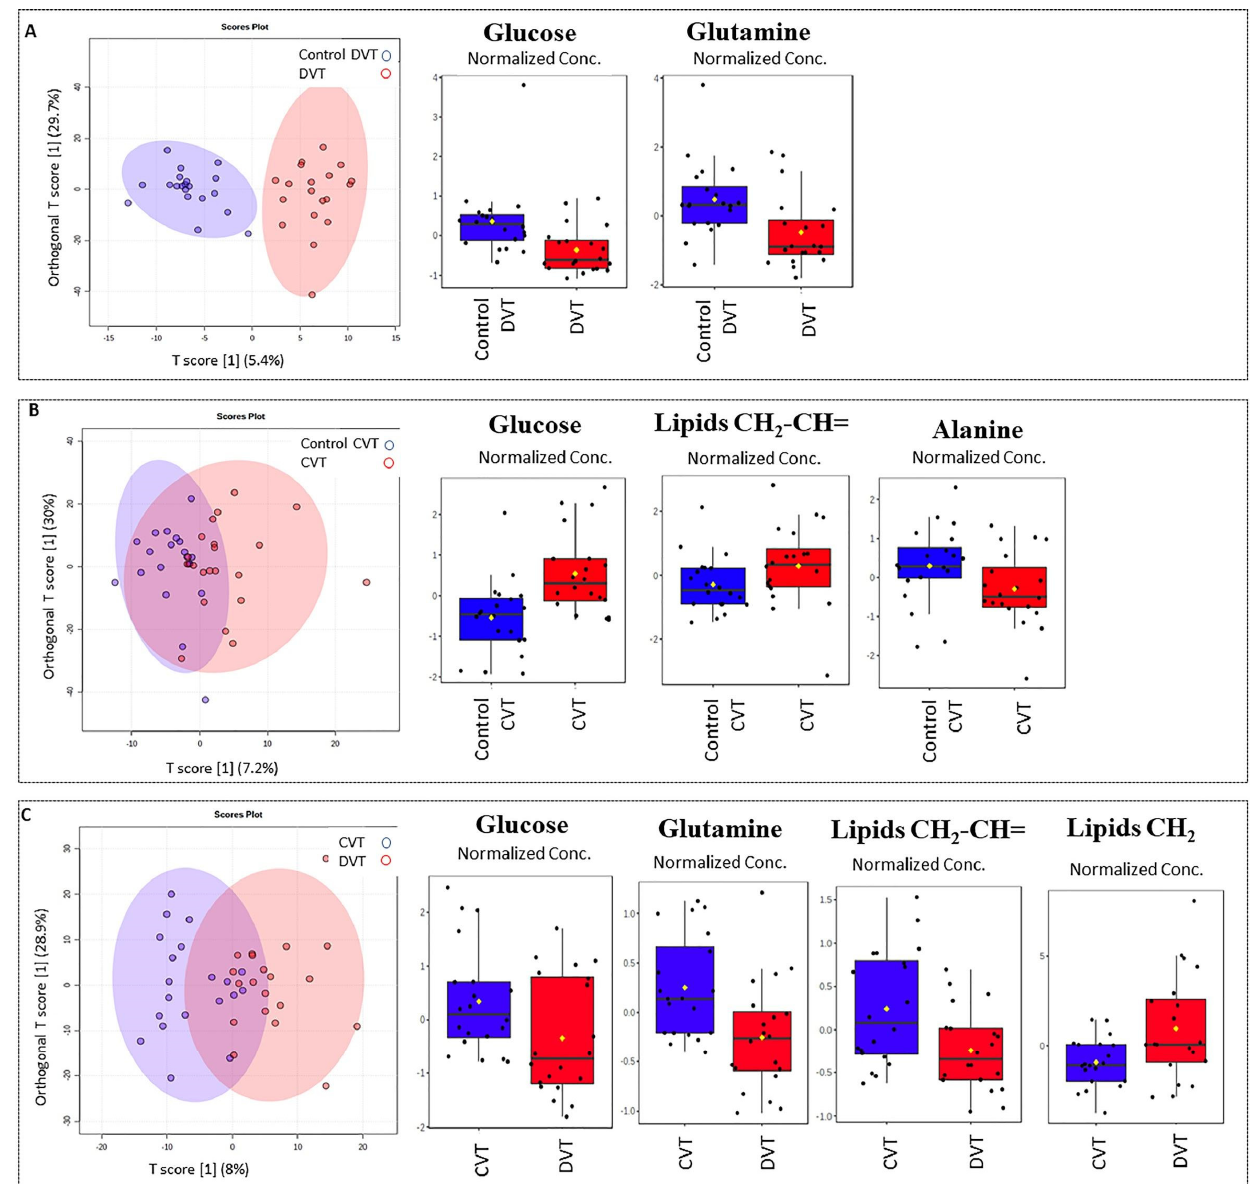
Figure 3. Illustration of results of OPLS-DA from 1 H-NMR CPMG data showing subgroups with the respective VIP responsible for class separations. The levels of metabolites, shown as Normalized Conc., were expressed as peak intensities. ( A ) DVT vs. DVT’s control R 2 X 30%, R 2 Y 35%, and Q 2 13%; ( B ) CVT vs. CVT’s controls R 2 X 30%, R 2 Y 10%, and Q 2 12%; ( C ) DVT vs. CVT patients R 2 X 8%, R 2 Y 10%, and Q 2